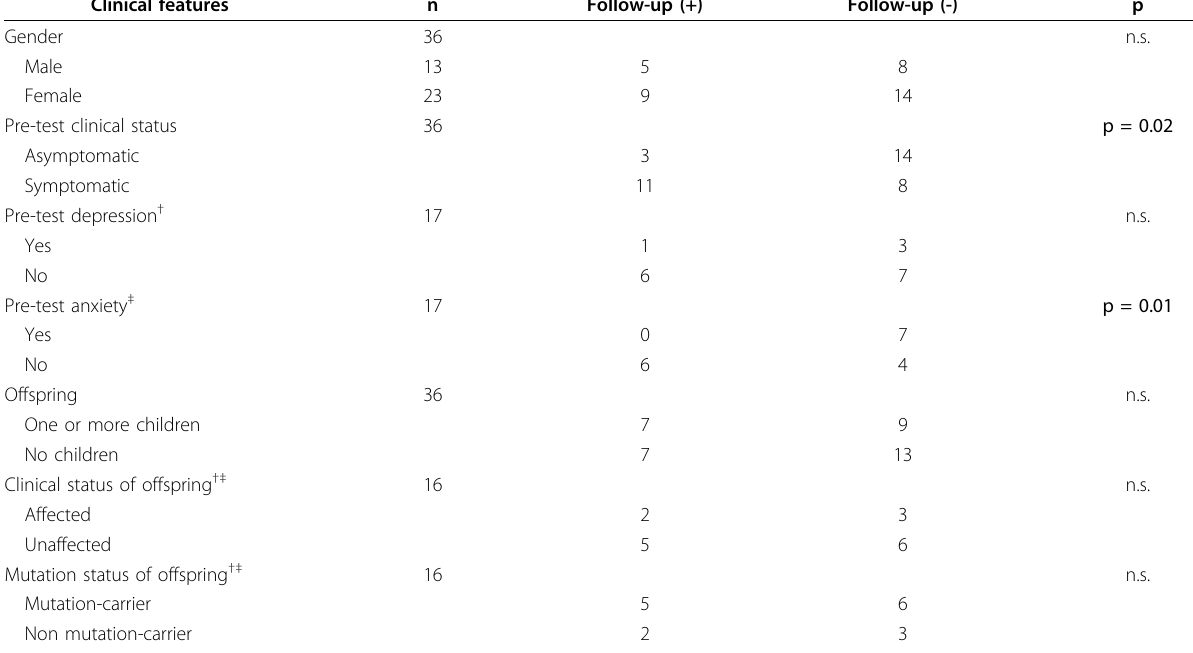
Table 3 Clinical correlates of adherence to tumor surveillance program Clinical features